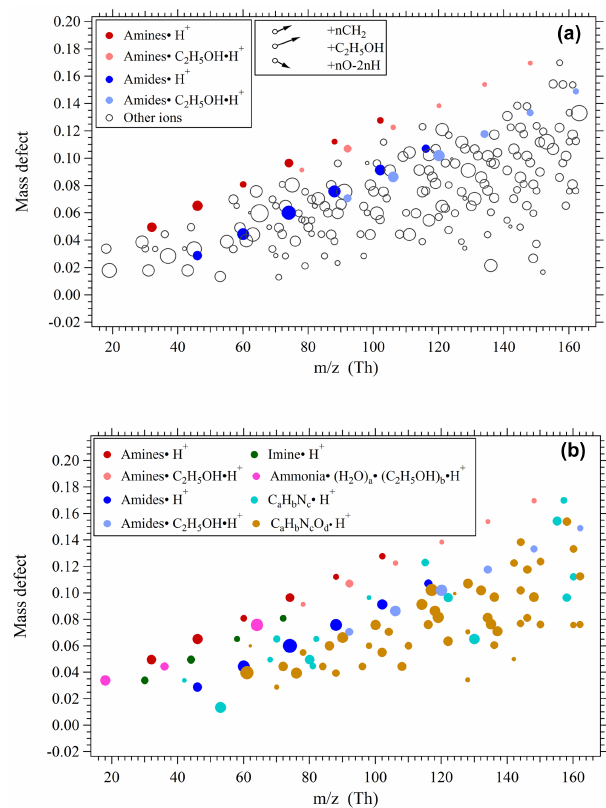
Figure 4. Mass defect diagram for (a) protonated amines (C 1 –C 6 ) and amides (C 1 –C 6 ) and their clusters with ethanol, together with other species with m/z less than 163Th in the ambient sample; and (b) all nitrogen-containing species with m/z less than 163Th in the ambient sample. Circle diameters are proportional to log 10 (count